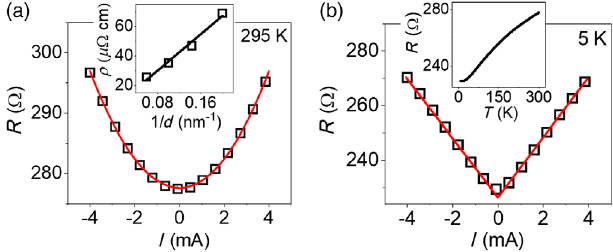
FIG. 1. (a) Resistance vs current for a 1 - μ m-long, 500-nm- wide, 5-nm-thick Pt wire deposited on etched Si substrate, at room temperature T ¼ 295 K. The curve is the best fit to the data with a quadratic function. Inset: Resistivity of Pt deposited on Si substrates vs inverse Pt thickness, at 295 K. (b) Same as (a), at T ¼ 5 K. Curve is a fit with the linear function R ð I Þ ¼ R ð 0 Þ þ α j I j , where α is a fitting parameter. Inset: the dependence of the wire resistance on temperature at I ¼ 0